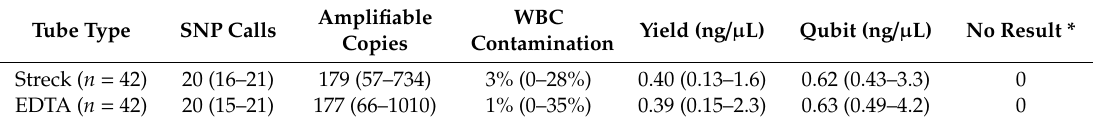
Table 1. Liquid IQ ® results for the Streck and EDTA samples.